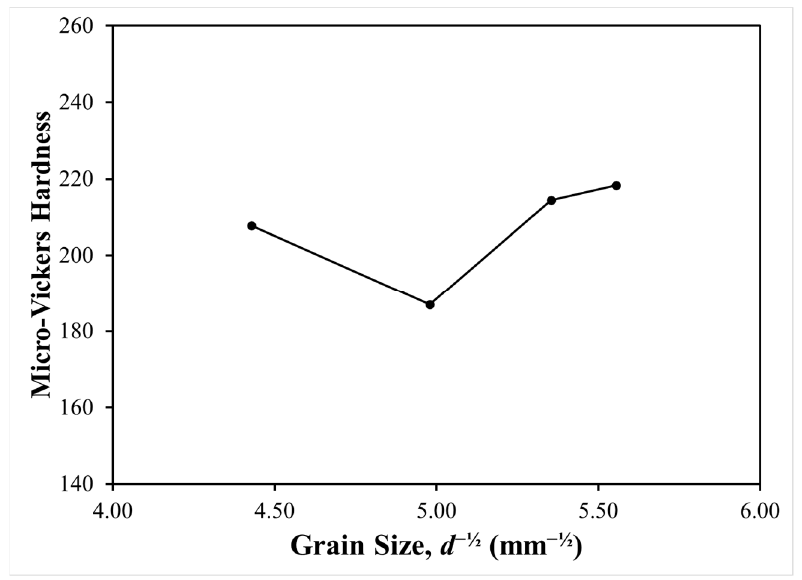
Figure 11. Effect of grain size on the micro-Vickers hardness.